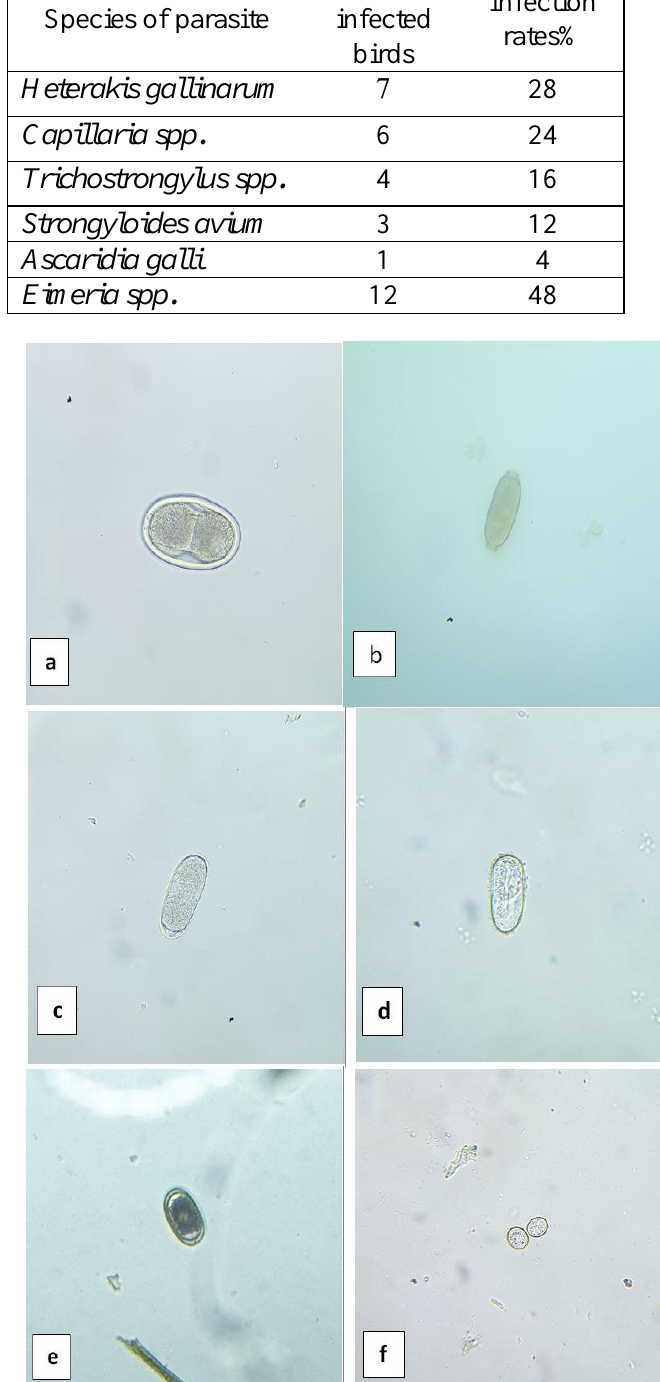
Table 1: The infection rates of nematodes and Eimeria spp. in turkeys in dropping samples. Species of parasite